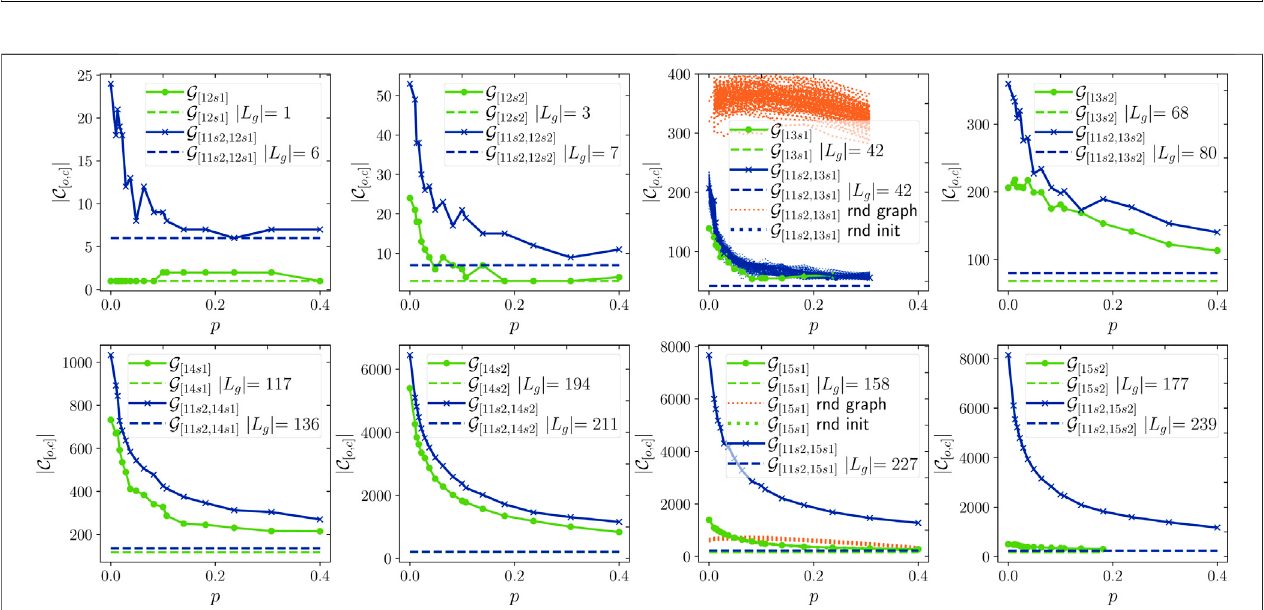
FIGURE 8 | Number of clusters as a function of p .